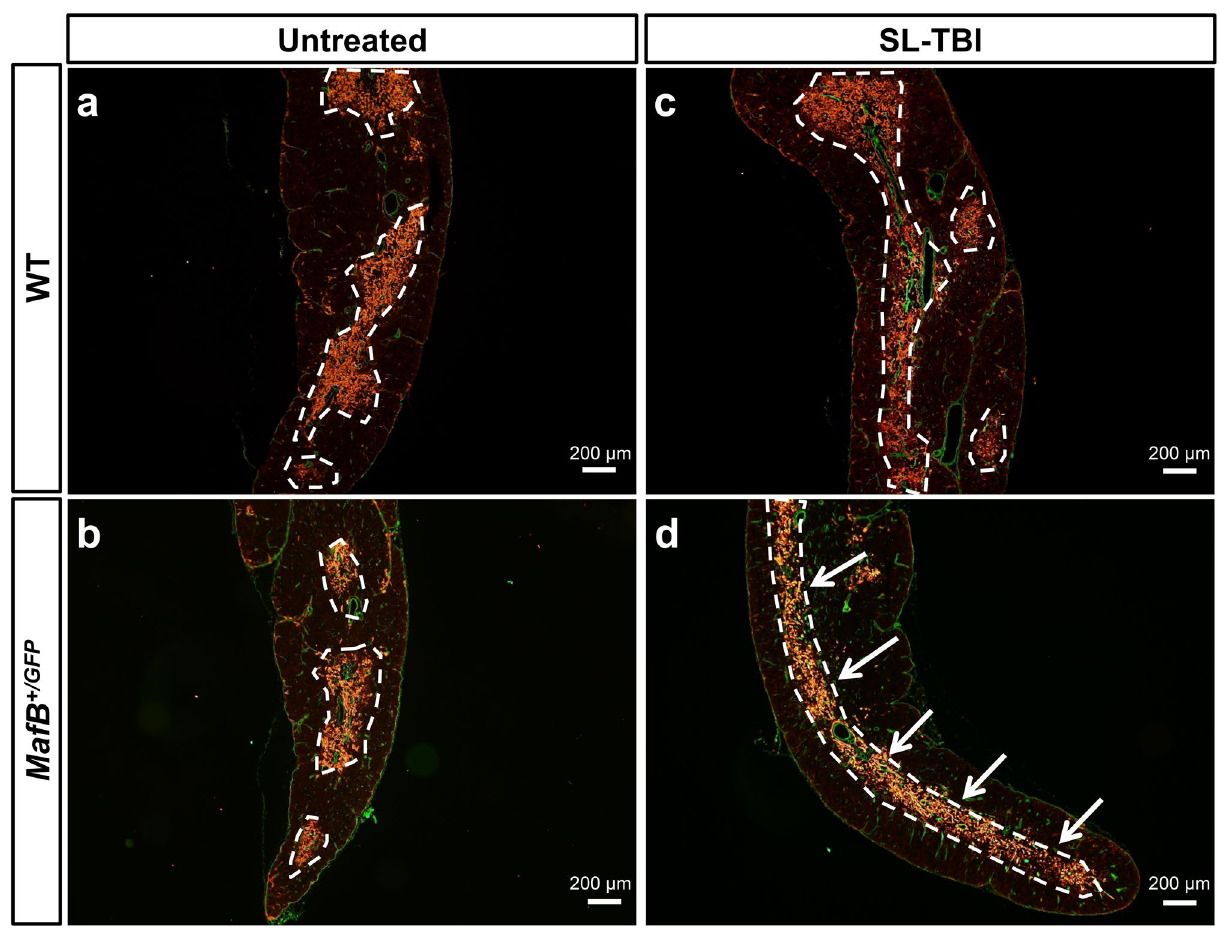
Figure 5. Thymi from MafB + /GFP mice displayed aberrant organization of medullary thymic epithelial cell (mTEC) clusters after SL-TBI. ( a – d ) ER-TR7 expression (green color, representing fibroblasts and other mesenchymal cells of the thymic capsule) and Keratin 14 expression (red color, representing mTECs) shown by immunofluorescence staining of 9-week-old MafB + /GFP and WT thymi frozen sections (transverse), 28 days after SL-TBI. The borders of Keratin 14 positive mTEC clusters are indicated by white dotted lines. Scale bar: 200 µm. Similar organization of Keratin 14 positive mTEC clusters was observed in ( a ) untreated WT thymi, ( b ) untreated MafB + /GFP thymi, and ( c ) SL-TBI-treated WT thymi. ( d ) Aberrant organization of mTEC clusters was prominently observed in SL-TBI-treated MafB + /GFP thymi, which often exhibited a single large mTEC cluster (indicated by white arrows). All data shown are representative results of 3 independent experiments using adult specimens from different litters (n =